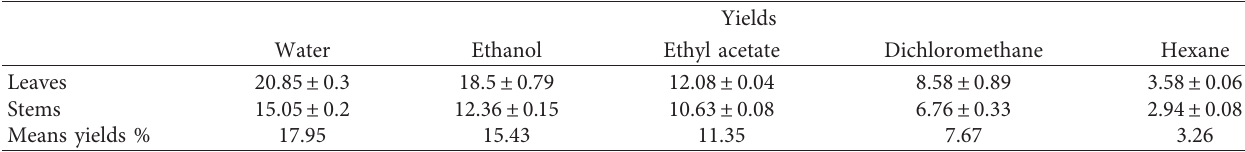
Table 3: Yields (%) of crudes’ extractions of Halimium halimifolium’s different